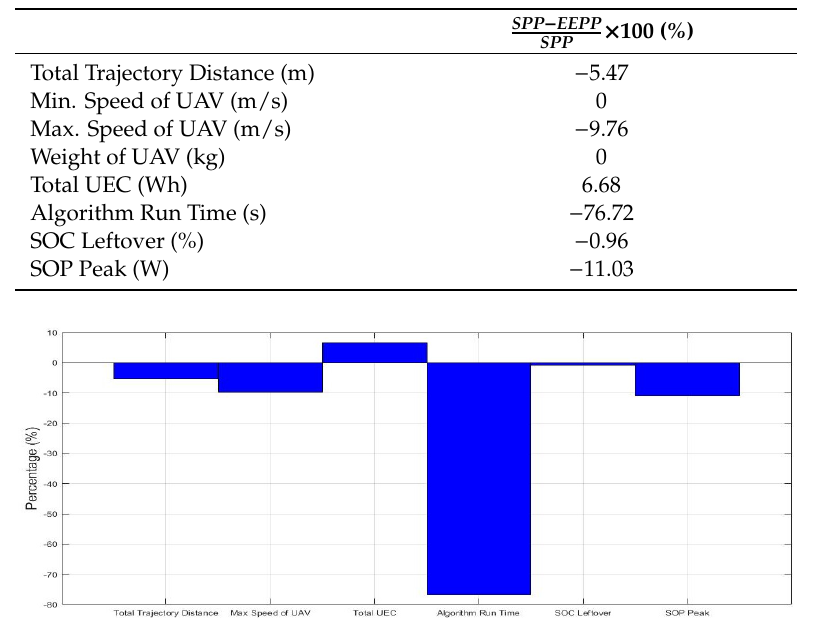
Figure 16. SOC and SOP comparison (experiment): ( a ) SOC and ( b ) SOP. Table 5. Comparison result in percentage (experiment).